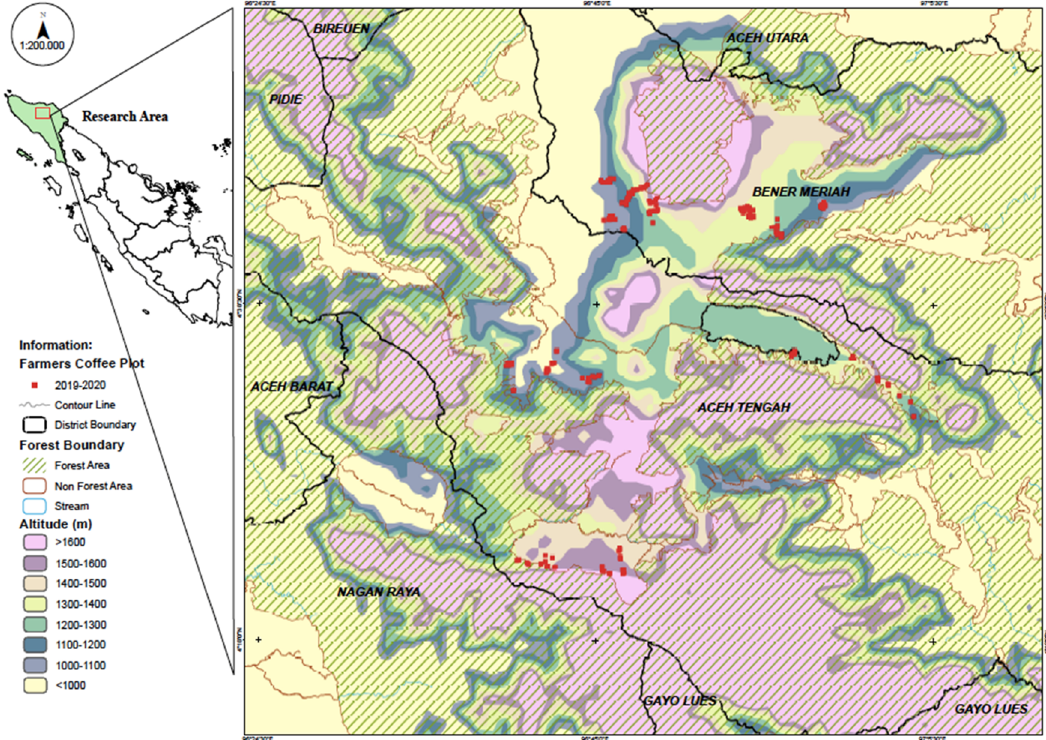
Figure 1: Map of Sumatera island, Indonesia, and research area with farmers ’ plots ( 234 plots )